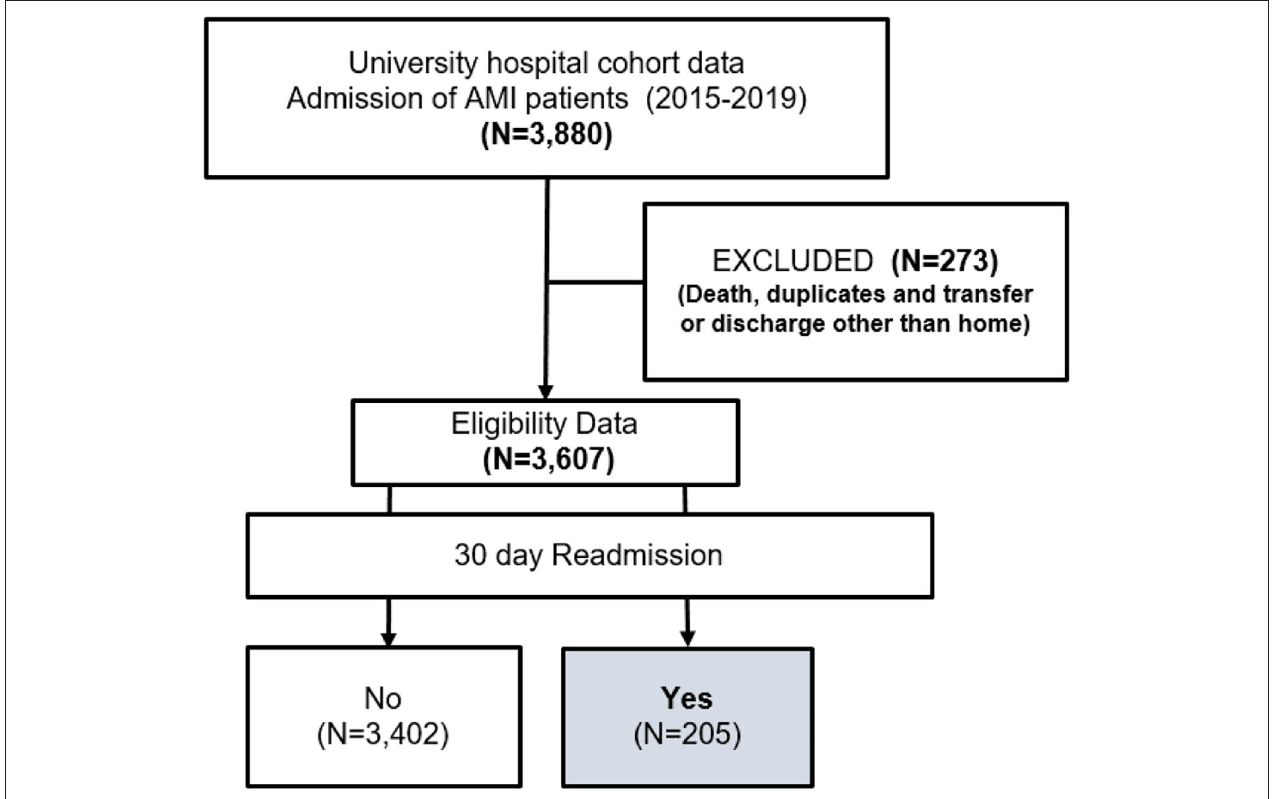
FIGURE 1 | Flow chart for selection process of study